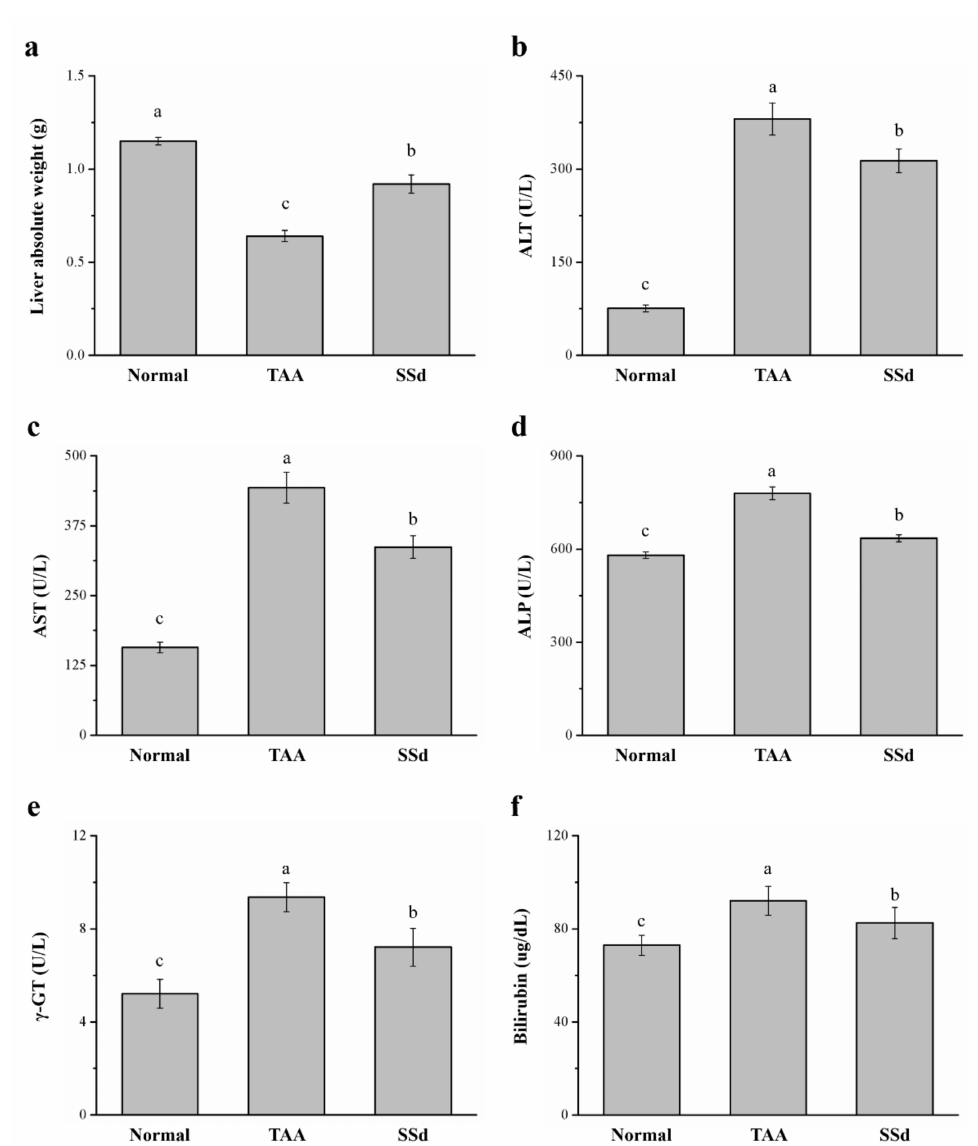
Figure 2. Changes in ( a ) liver weight and serum ( b ) ALT, ( c ) AST, ( d ) ALP, ( e ) γ -GT, and ( f ) bilirubin levels in the control, TAA, and SSd groups over 8 weeks. All data are reported as means ± SD ( n = 8). a–c Data with unlike letters above the columns were significantly different on one-way ANOVA, and Duncan’s test at p < 0.05 was used to compare the means of the three groups. ALT, alanine aminotransferase; AST, aspartate aminotransferase; ALP, alkaline phosphatase; γ -GT, γ